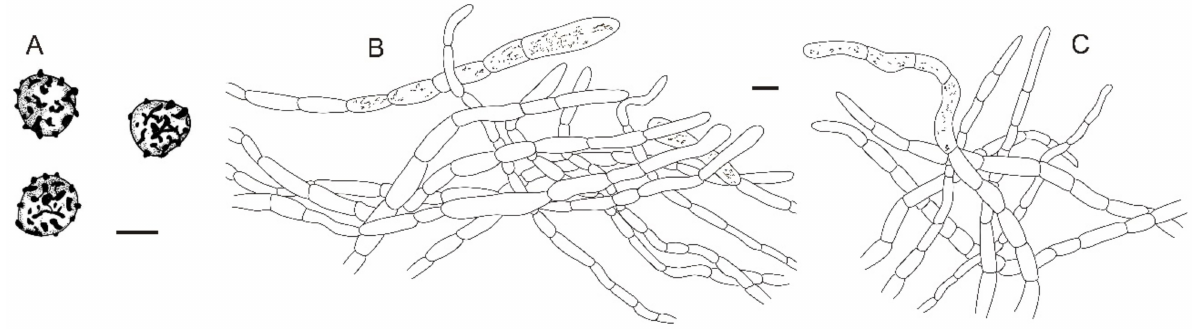
Figure 26. Microscopic features of Russula yanshanensis (BJTC C561). ( A ) Basidiospores. ( B ) Hyphal terminations near the pileus margin. ( C ) Hyphal terminations near the pileus center. Scale bar: ( A ) = 5 µ m; ( B , C ) = 10 µ